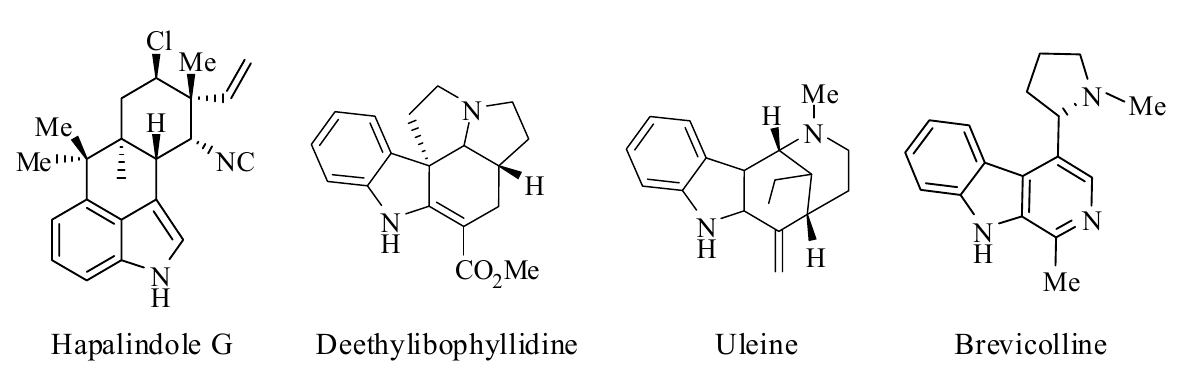
Figure 1. Indole